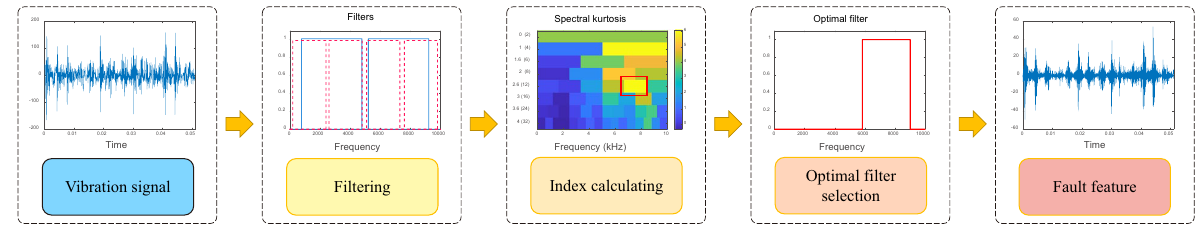
Fault featureIndex calculating